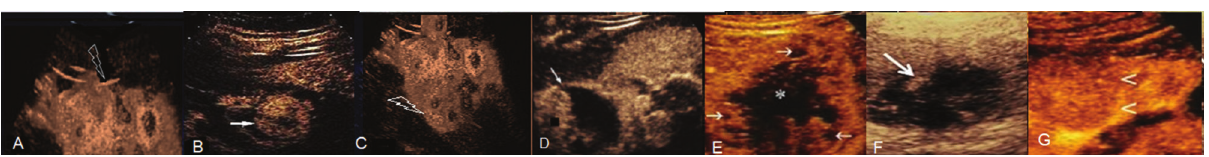
Figure 6 - Contrast-enhanced ultrasound images of the kidney. A: Clear cell renal carcinoma. B: Papillary renal cell carcinoma-type I. C: Papillary renal cell carcinoma-type II. D: Infiltrative urothelial renal cell carcinoma. E: Collecting duct renal cell carcinoma. F: Angiomyolipoma. G: Oncocytoma.